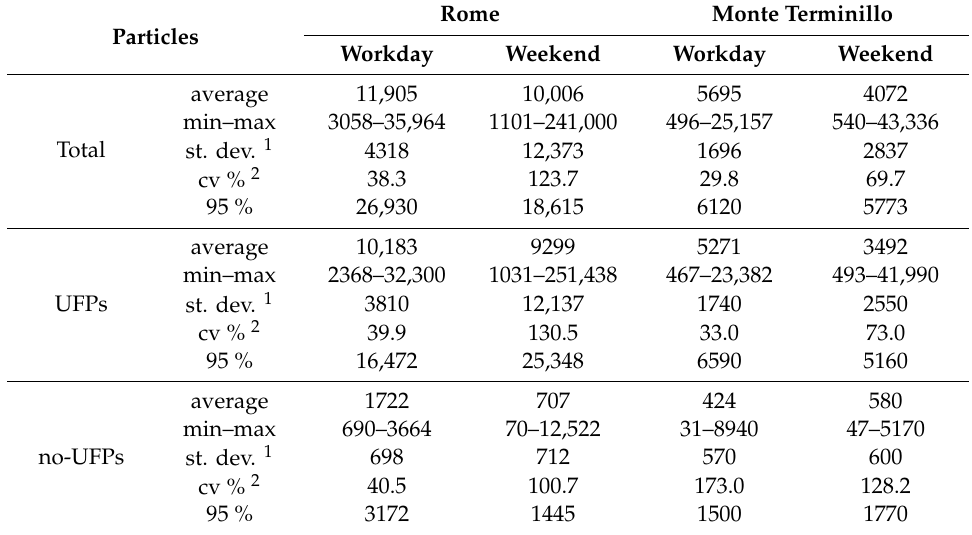
Table 1. Typical average number concentration (# cm − 3 ), standard deviation, and 95th percentile of total particles, ultrafine particles (UFPs), and non-ultrafine particles (non-UFPs) determined in the two sites during workdays and